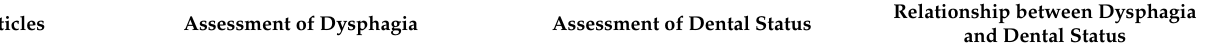
Table 2. Criteria used to establish a link between dental status and